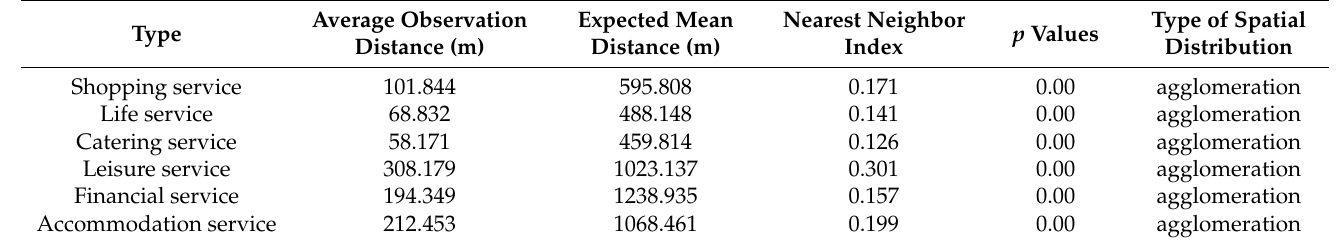
Table 5. The nearest neighbor index of different types of market services industries in Wuhan city’s new urban